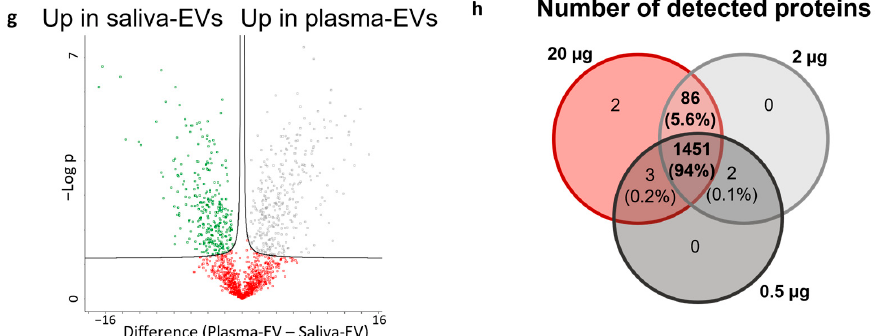
Figure 4. Mass spectrometry-based proteomics of saliva- and plasma-EVs. ( a ) We compared saliva-EVs to plasma-EVs and found that albumin, a contaminating protein, was more abundant in plasma-EVs, while there was no significant difference in APOA1. Several common transmembrane ( b ) and cytosolic ( c ) EV-associated proteins showed a higher expression in saliva-EVs compared to plasma-EVs. ( d ) A multi-scatter plot of saliva and plasma-EVs indicates strong intra-group correlations which are higher in the saliva-EVs compared to plasma-EVs. Unsupervised hierarchical clustering ( e ) and principal component analysis ( f ) could correctly cluster all samples. ( g ) A volcano plot was generated, depicting proteins which were upregulated in saliva-EVs (green squares), upregulated in plasma-EVs (gray squares) or with similar expression between the two groups (red squares). ( h ) To determine the minimum required amount of total protein for the detection of sufficient proteins, 0.5 µ g, 2 µ g and 20 µ g of protein were analyzed. Two micrograms protein were deemed sufficient, with a minimal difference to 20 µ g. * p = 0.05 ** p = 0.01, *** p = 0.001, **** p = 0.0001, ns—non-significant by two-sample t -test with permutation-based FDR. Error bars represent standard deviation.